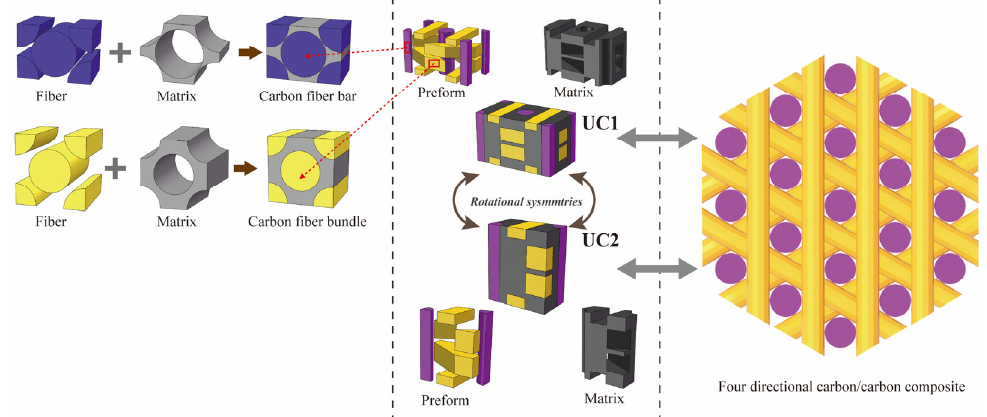
Figure 1. Framework of the entire solving process.